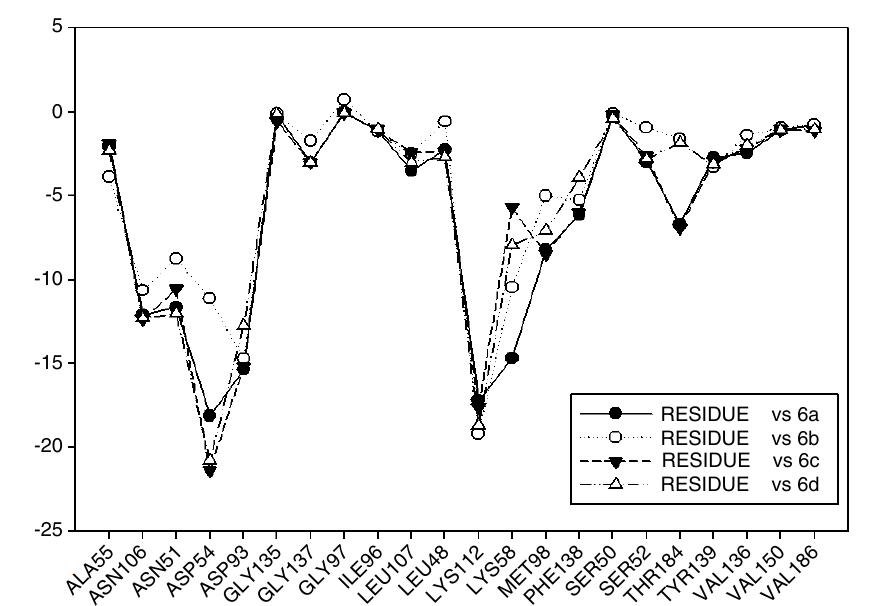
Figure 13. Interaction energies of 11-ketone geldanamycin analogues.